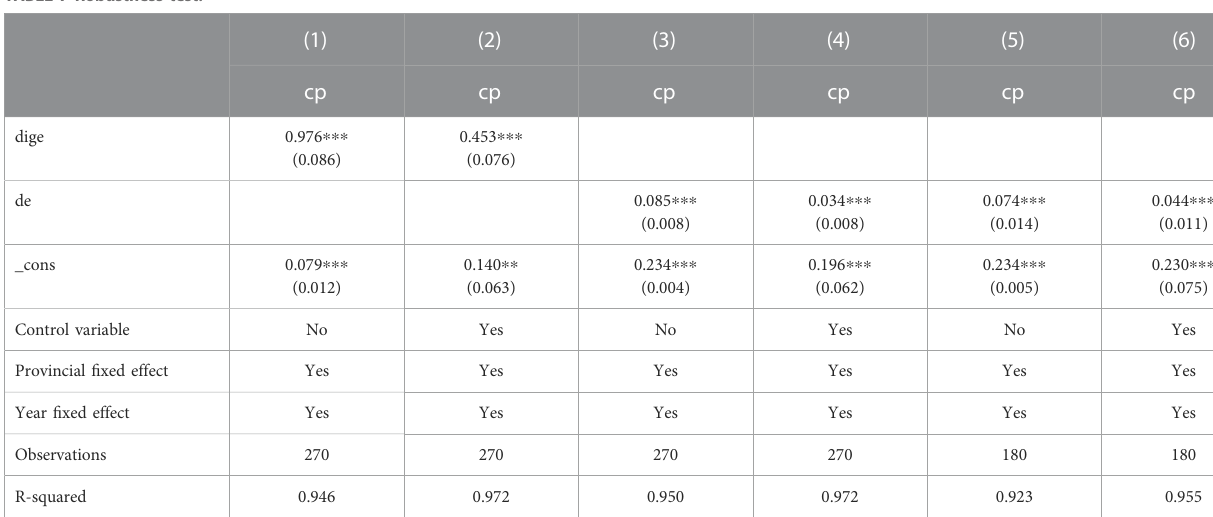
TABLE 7 Robustness